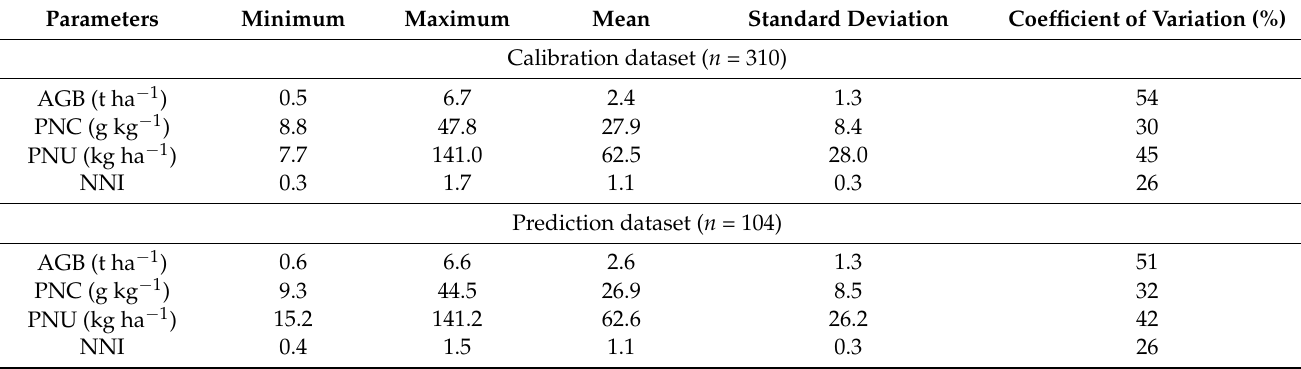
Table 5. Descriptive statistics of corn N status indicators at around V9 growth stages across site-years.